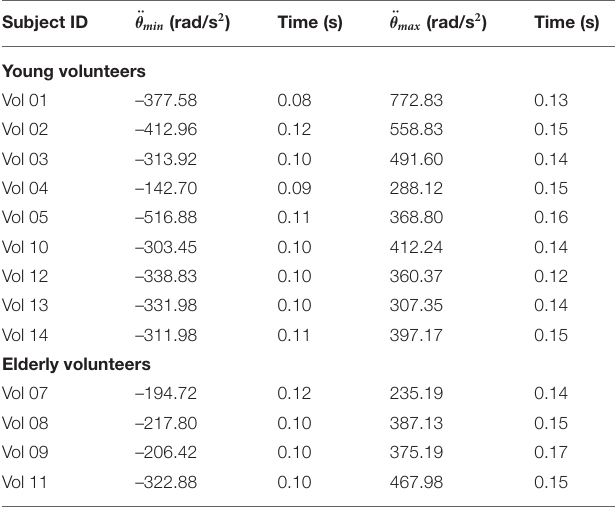
TABLE 5 | Peak head angular